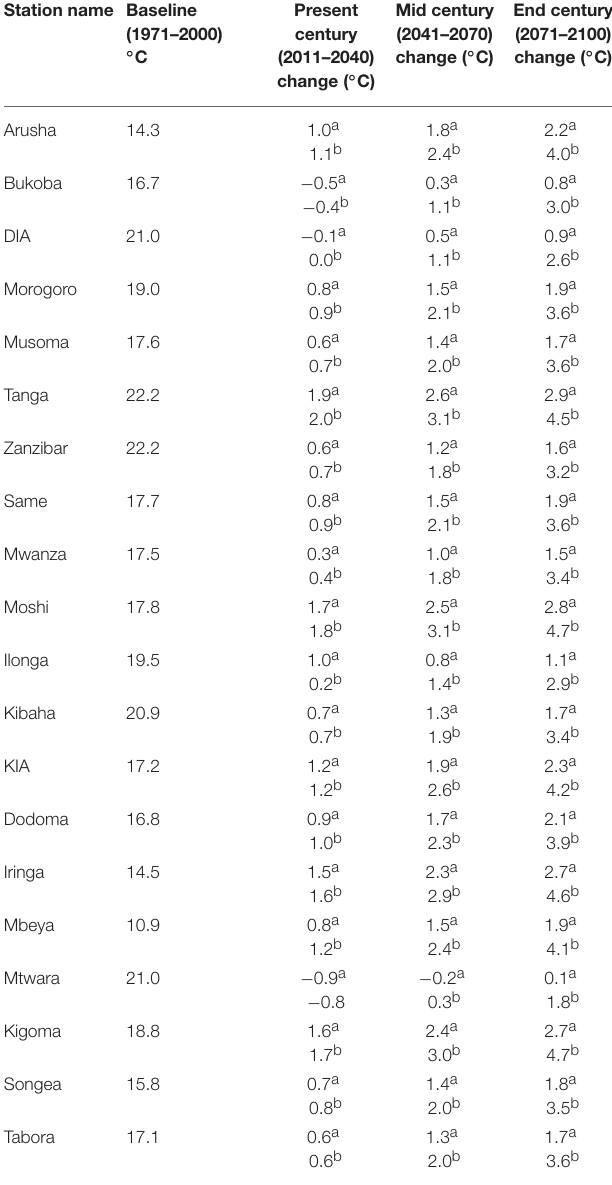
TABLE 4 | Projected change in minimum temperature across representative regions over